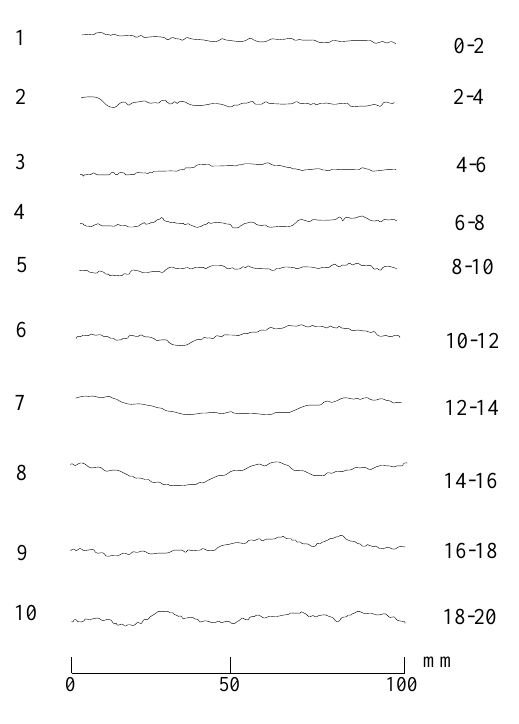
Fig.1. Standard roughness profile Figure 1: Standard roughness profile